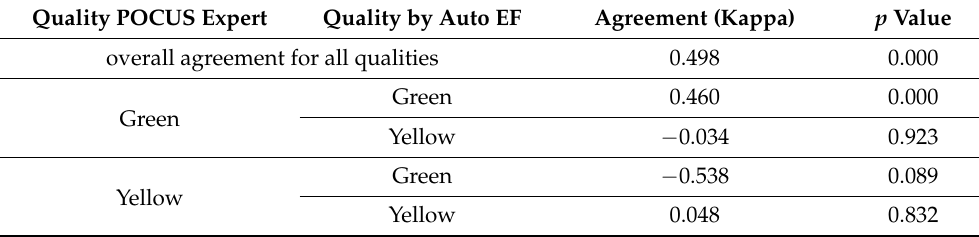
Table 2. Ejection Fraction Stratified